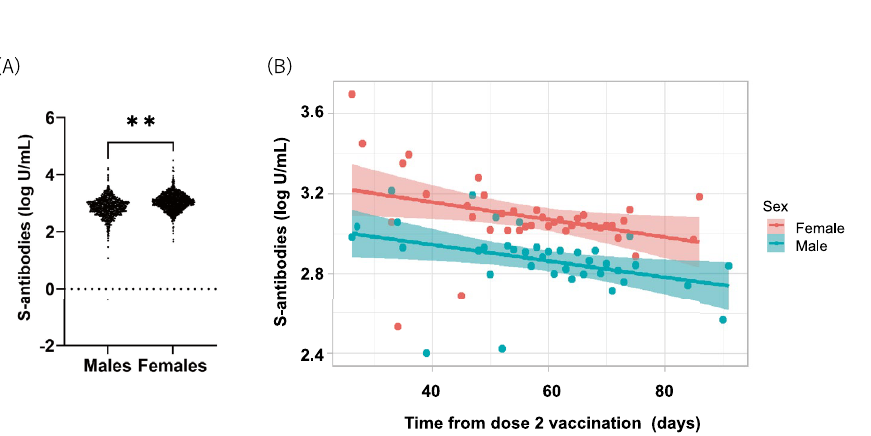
Table 2. Seroprevalence among healthcare workers according to the risk of exposure and professional category.